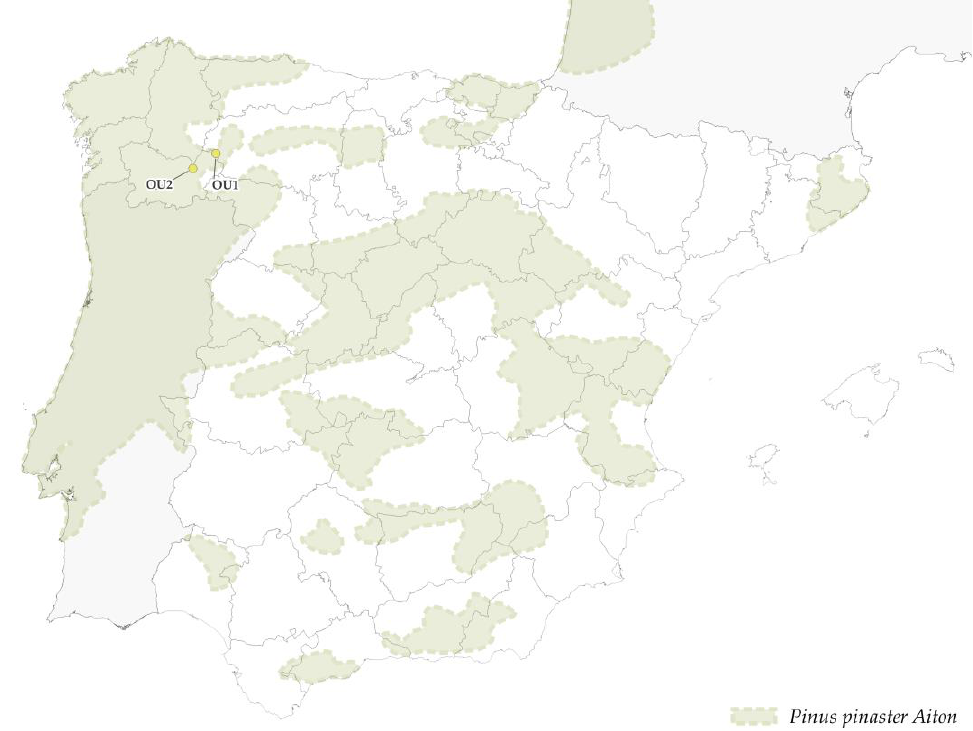
Figure 21. Distribution map of the species Pinys pinaster Aiton and location of the case studies identified as belonging to this species. Map drawn up by the authors using information obtained from the database Chorological Data for the Main European Woody Species